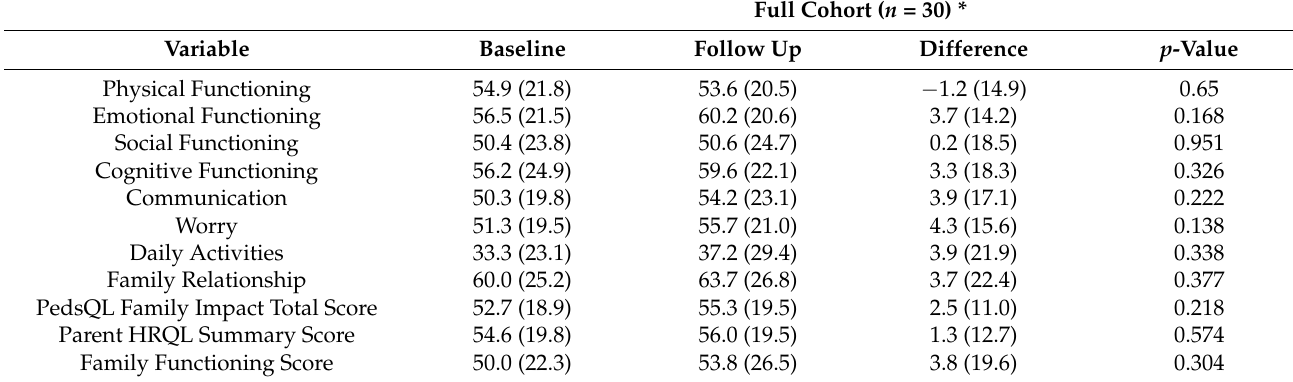
Table 1. PedsQL—Family Impact Module.